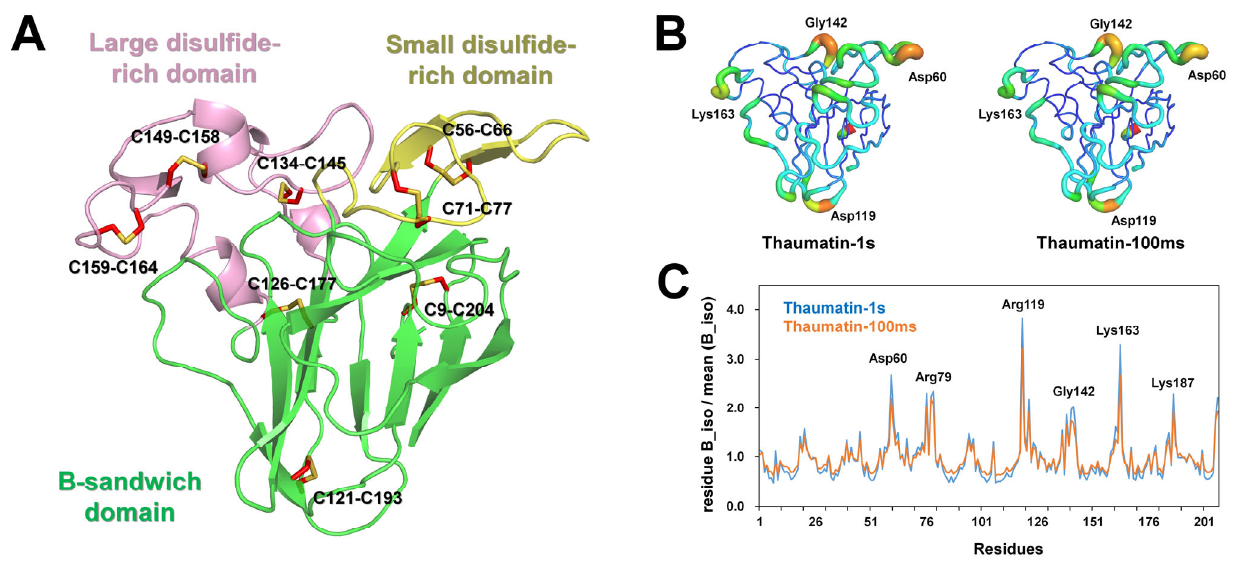
Figure 4. Crystal structure of thaumatin. ( A ) Thaumatin consists of β‐ sandwich (green), small disul ‐ fide ‐ rich (yellow), and large disulfide (pink) domains. ( B ) B ‐ factor putty representation of Thau ‐ matin 1s and Thaumatin 100ms . ( C ) Normalized mean B ‐ factors of Thaumatin 1s and Thaumatin 100ms .